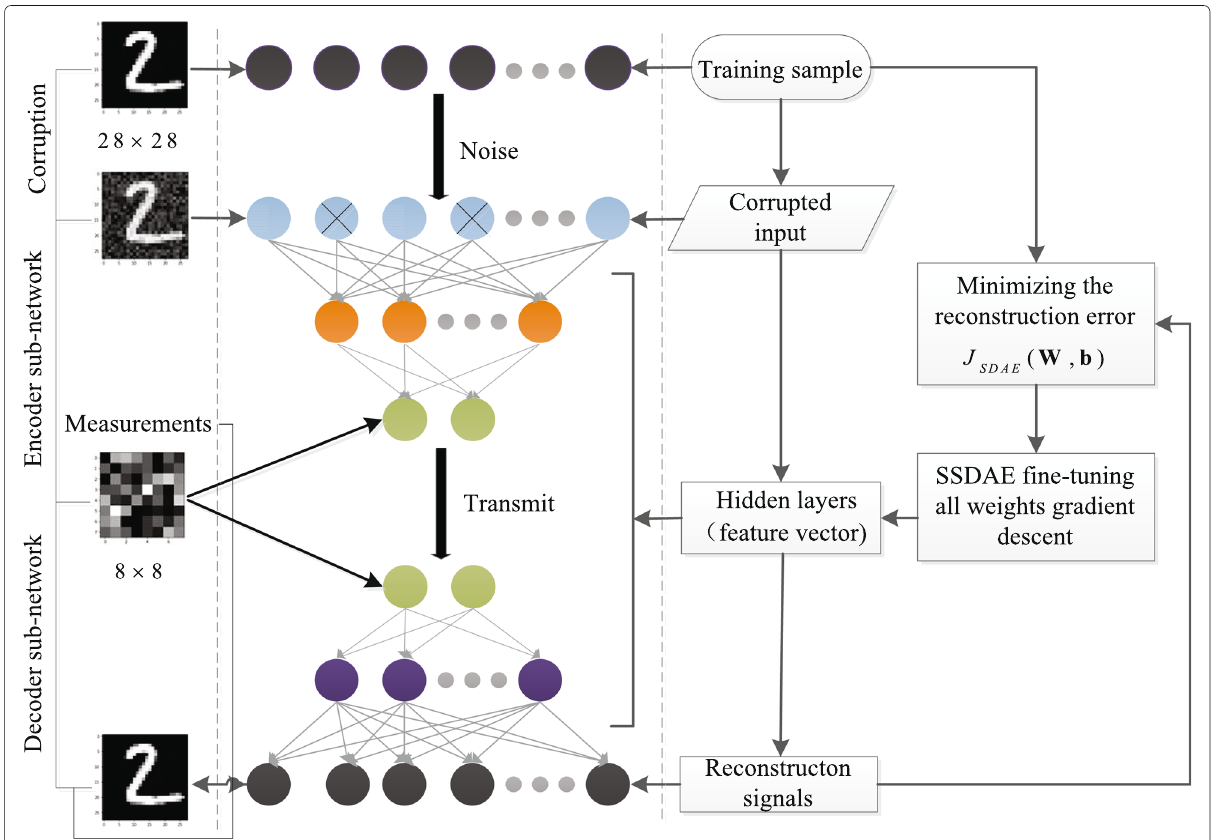
Fig. 2 Architecture of the SSDAE_CS Layer_5 when M = 64